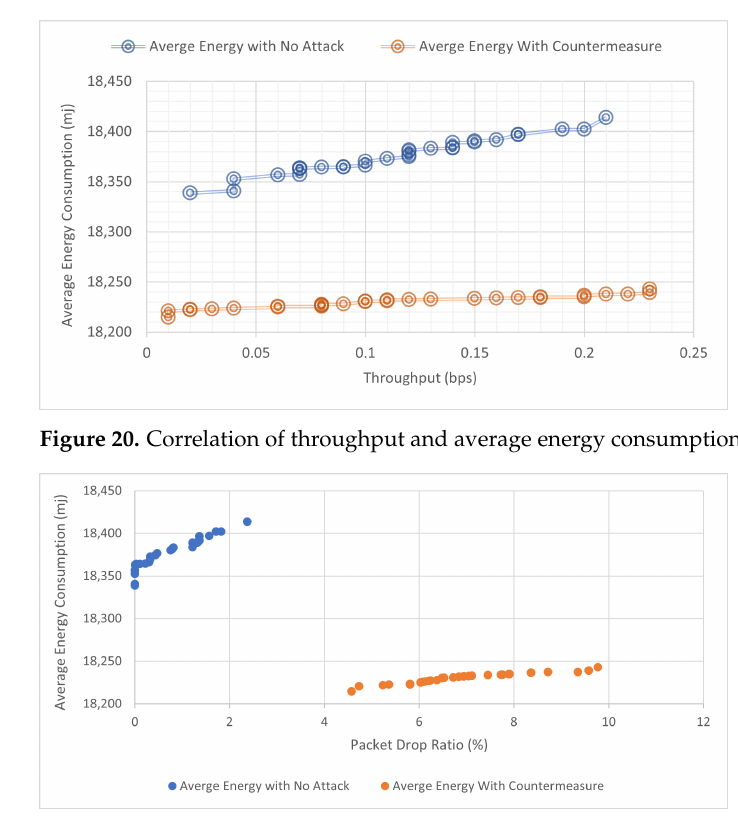
Figure 21. Correlation of packet delivery ratio and average energy